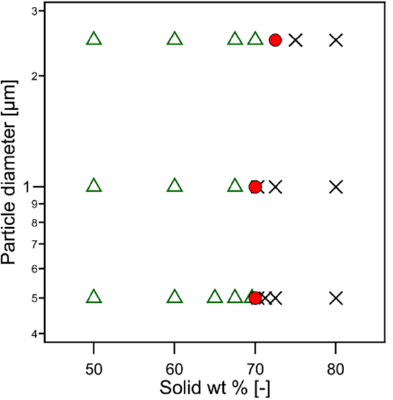
Figure 2. States diagram of the mixtures of silica particles with different diameters of 0.5, 1.0, and 2.5 µ m and deionized water: dispersed suspension ( (cid:52) ), climbing suspension ( • ), and undispersed ( ×